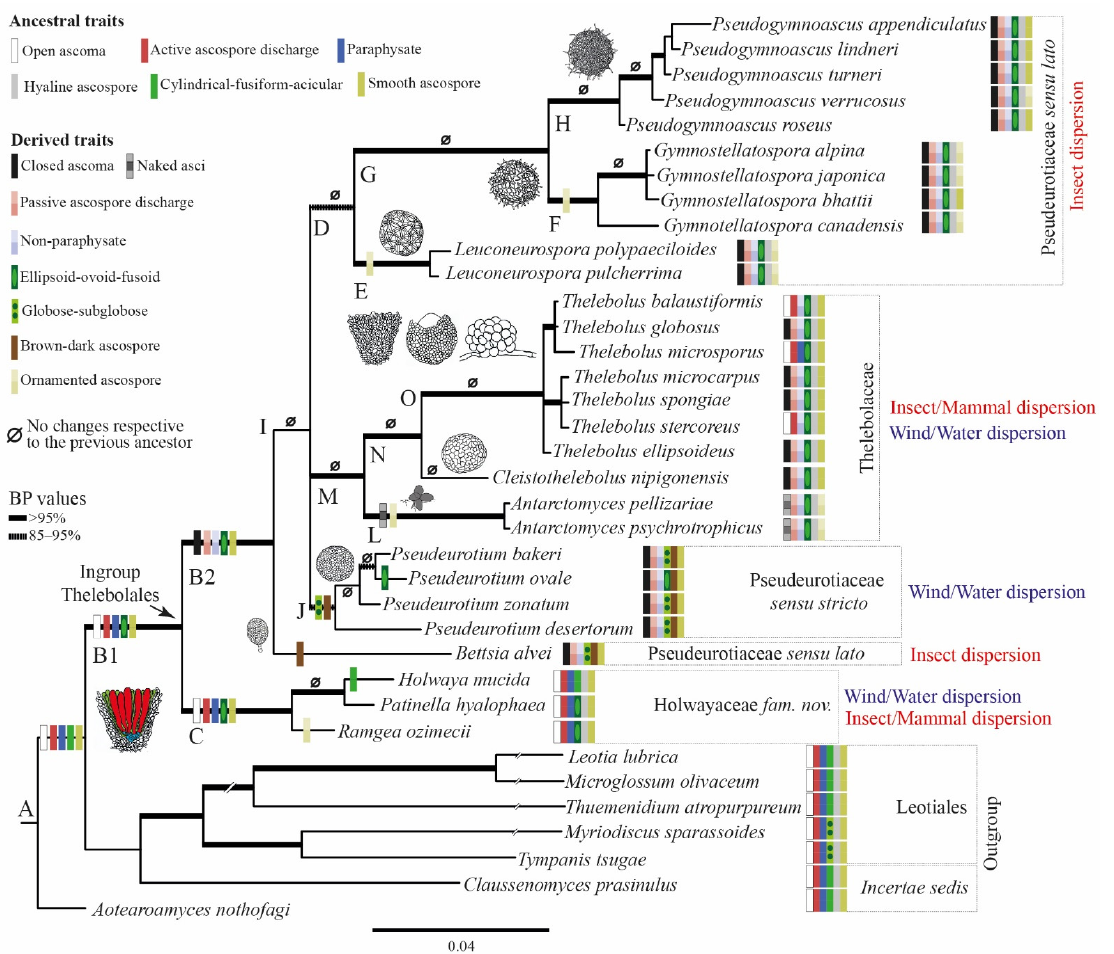
Figure 5. Hypothetical evolution of traits represented over the consensus Bayesian tree for Thelebolales based on the results of the reconstruction of ancestral states. Thick branches have bootstrap support (Bps) values > 95%. Ascoma morphology, as well as dispersal hypothesis, are represented for each clade.